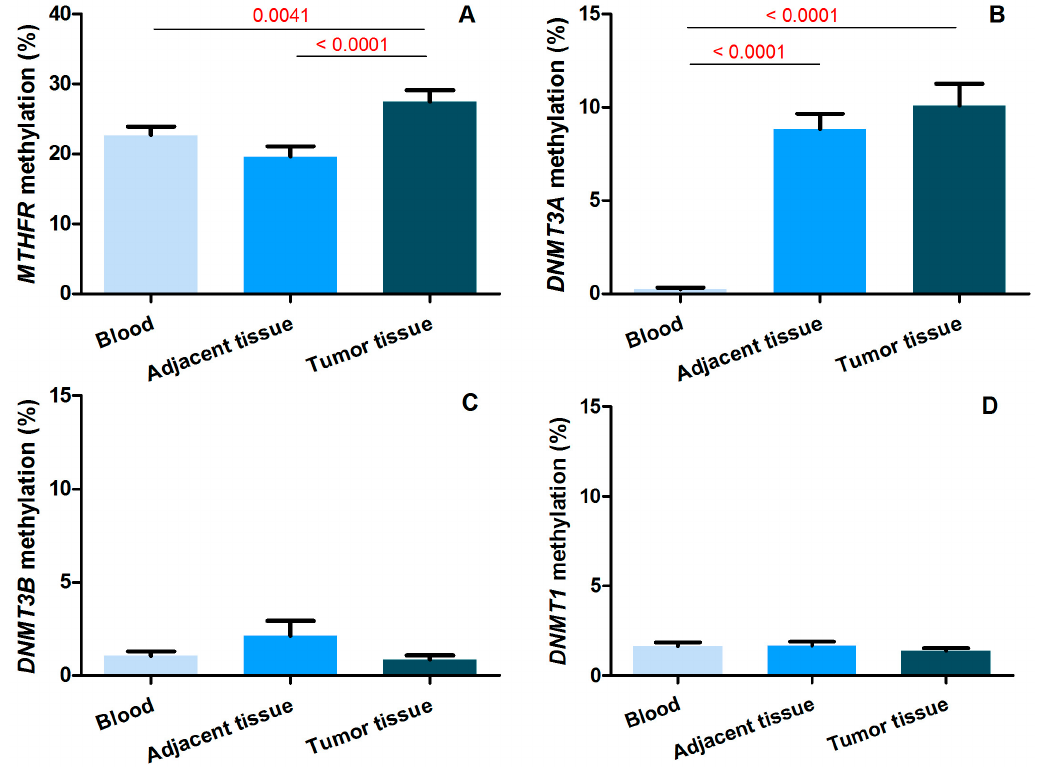
Figure 1. Methylation levels (%) of the studied genes (( A ) MTHFR ; ( B ) DNMT3A ; ( C ) DNMT3B ; and ( D ) DNMT1 ) in blood, tumor tissue and adjacent thymic tissue of thymoma-associated MG (TAMG) patients for whom adjacent tissue was available ( n = 44). The significant p -values (in red) refer to t -tests for paired samples.